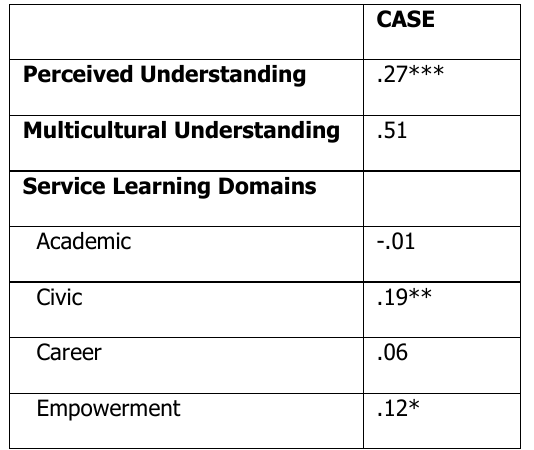
Regression coefficients of CASE courses compared to the control course